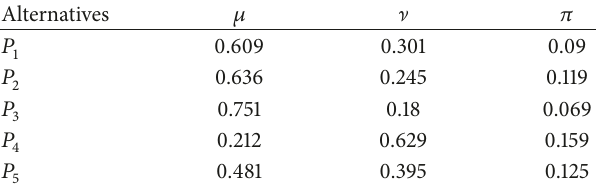
Table 6: 𝐵𝑁𝑥 𝑖 values.